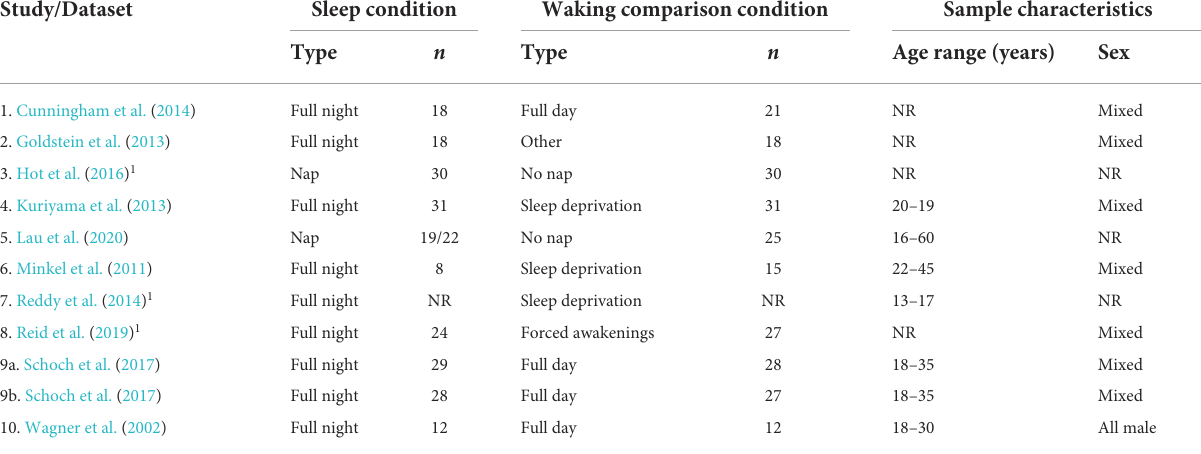
TABLE 3 Datasets included in the narrative analysis: Study design, conditions, and sample characteristics ( N = 10).